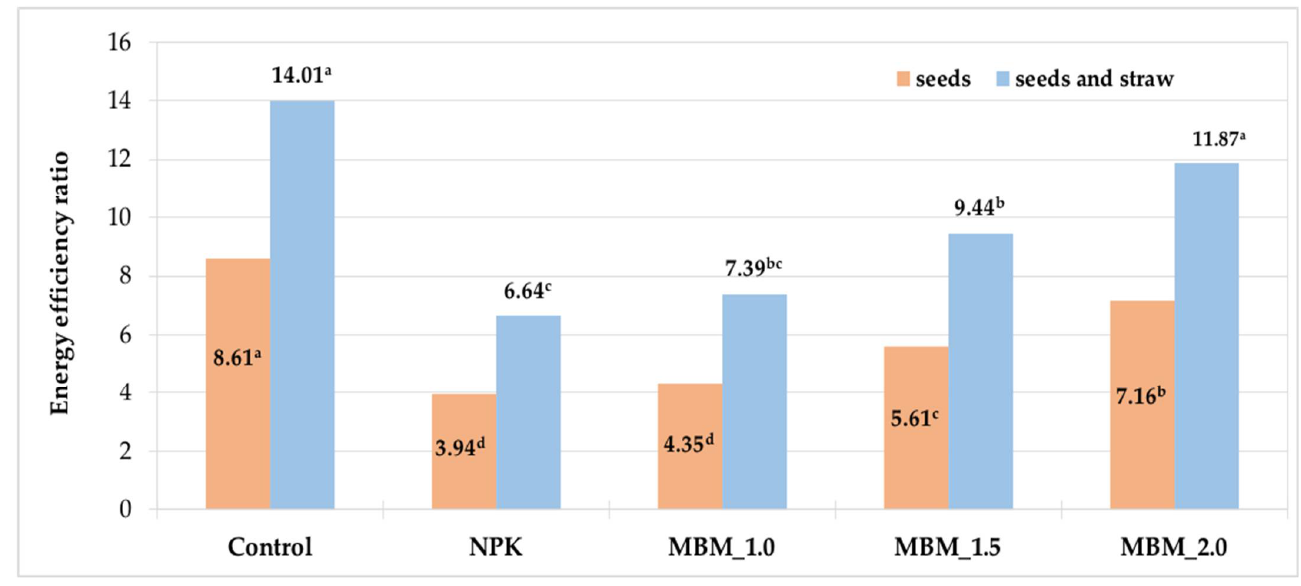
Figure 2. Energy efficiency ratio in the production of winter oilseed rape (across years). Means with the same letter do not differ significantly at p ≤ 0.05 in Tukey’s HSD test. The absence of letters denotes the non-significance of main effects.